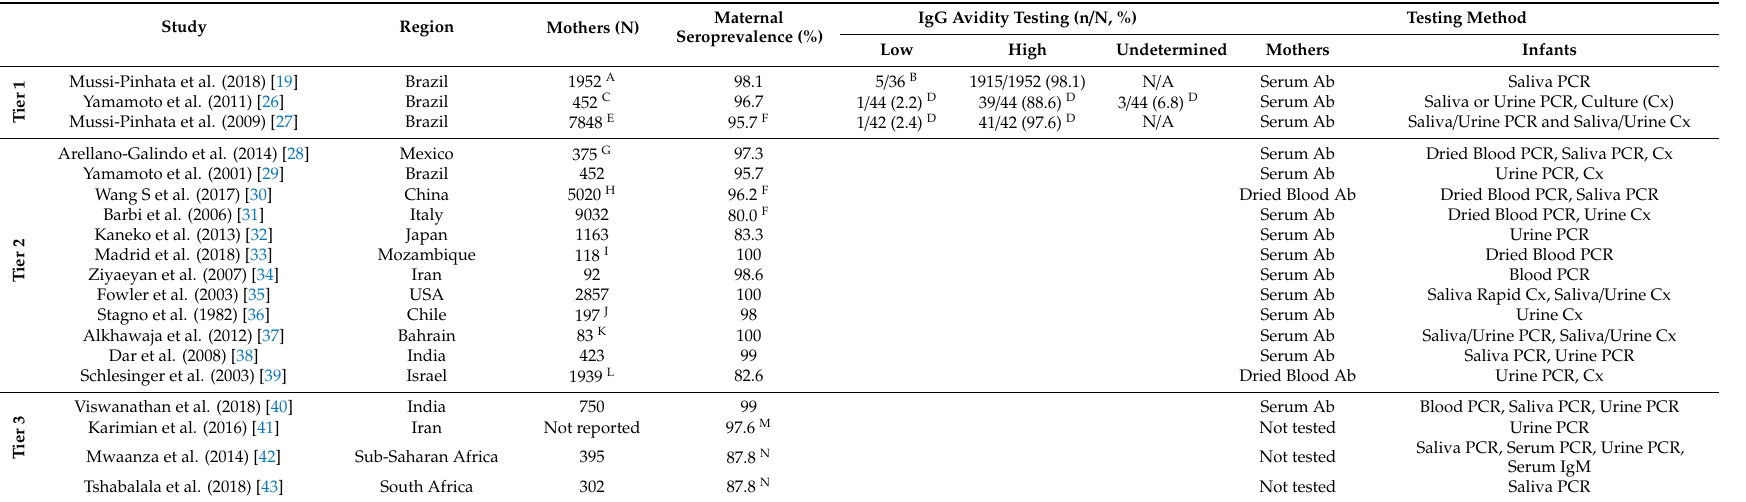
Table 1. Summary of study methods for assessing congenital cytomegalovirus (cCMV) birth prevalence in highly seroprevalent